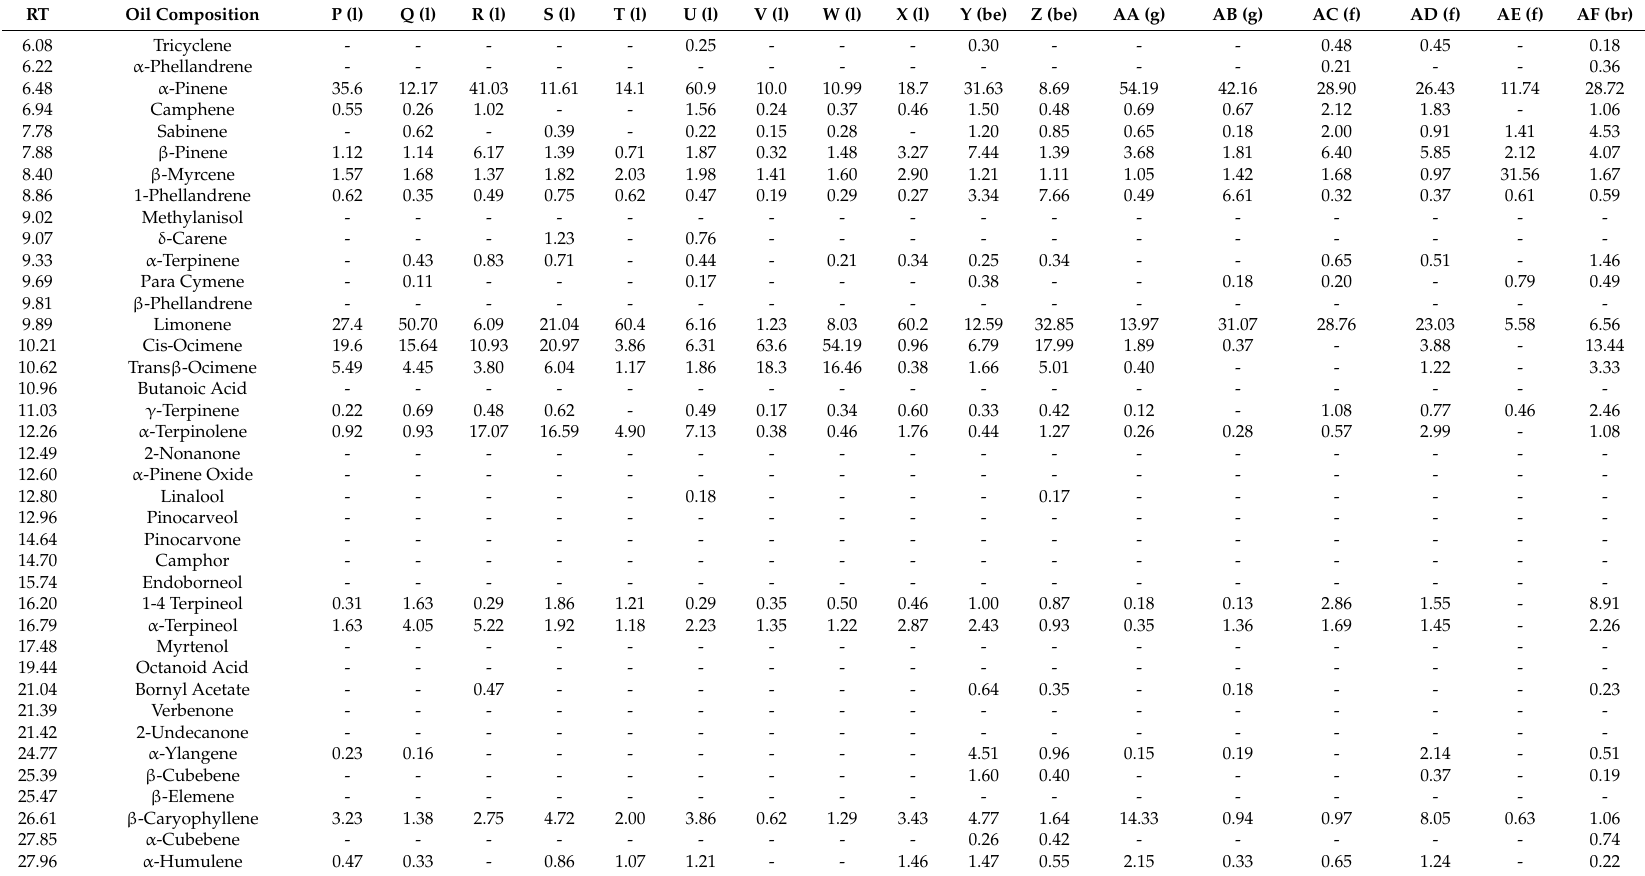
Table 2. Oil composition of P . terebinthus